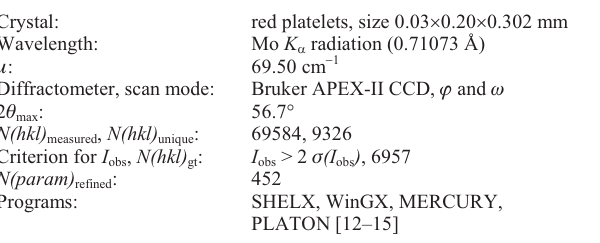
Table 1. Data collection and